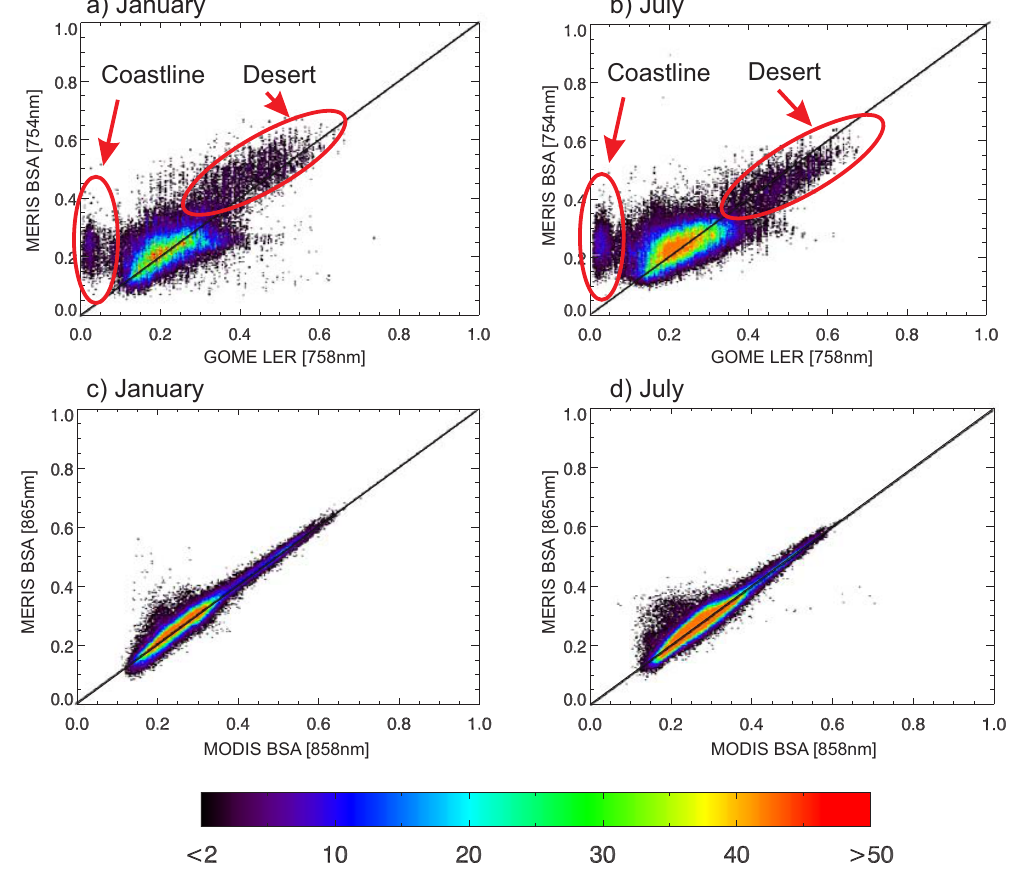
Fig. 3. Scatter density plots of MERIS BSA as a function of GOME LER and MODIS BSA for January and July for the NIR wavelength region. Only snow/ice-free grid cells over land are